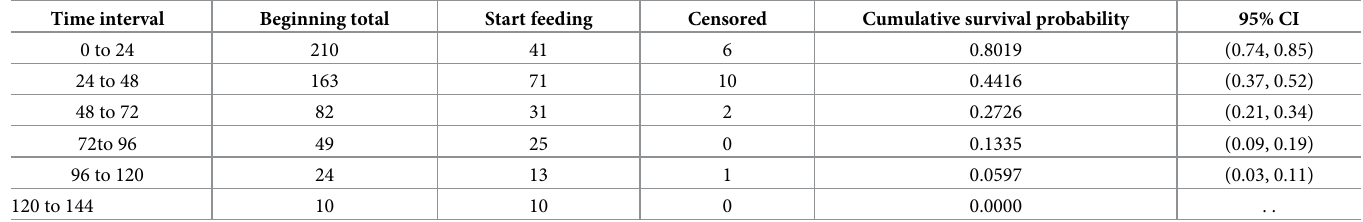
Table 3. Survival probabilities to start TF among neonates admitted in NICU of DMCSH, FHCSH, and TGCSH comprehensive specialized hospitals, Amhara, Northwest Ethiopia, 2020. Time interval